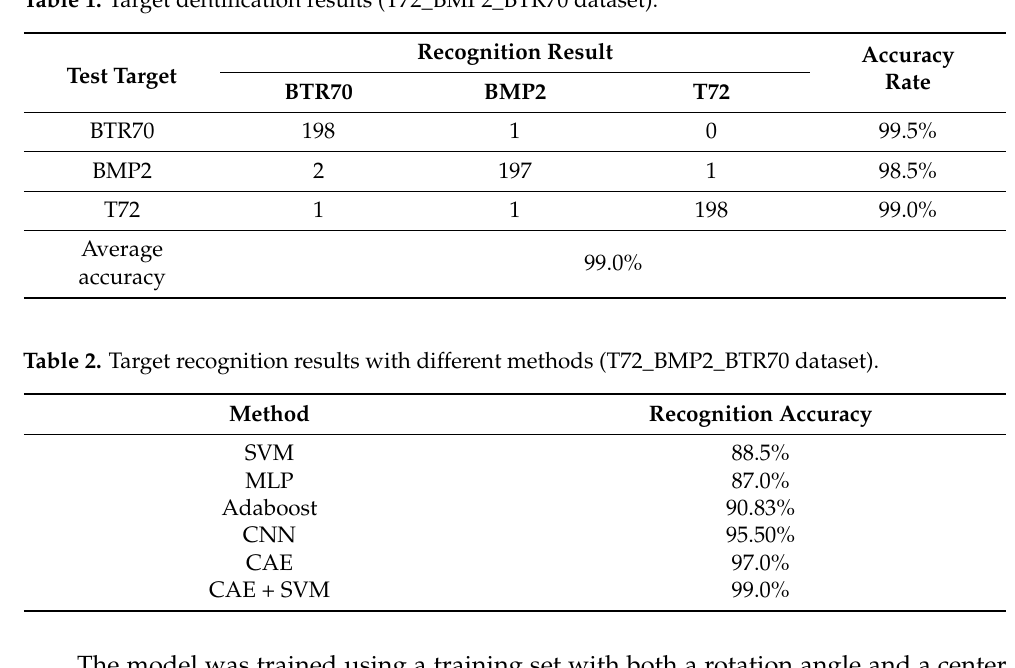
Table 1. Target dentification results (T72_BMP2_BTR70 dataset).